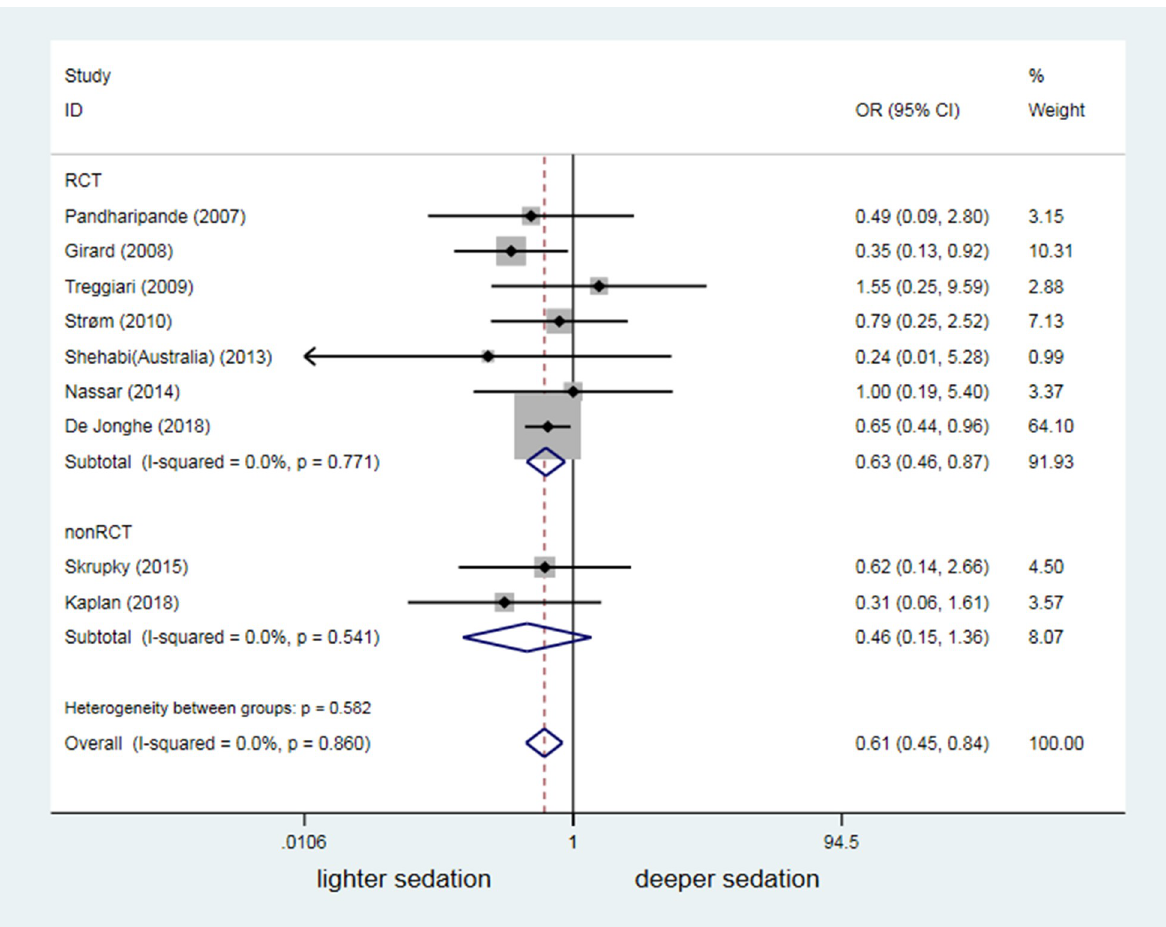
Fig 7. The impact of discrepancy in depth of sedation on frequency of agitation-related adverse events.